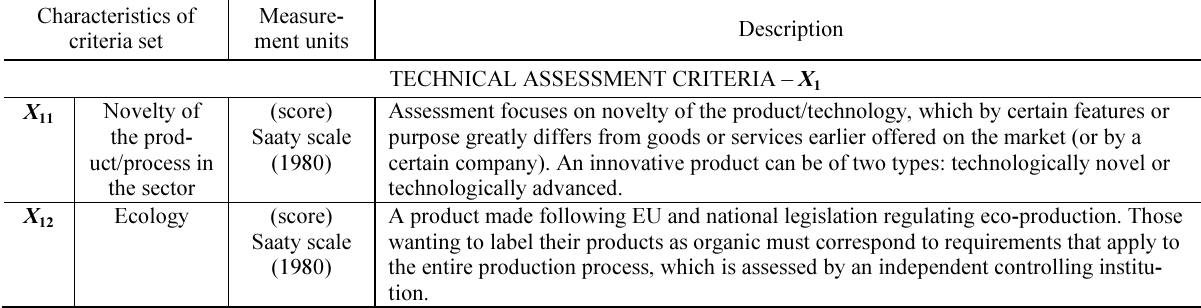
Table 1. Objectives used to assess the micro environment for technology deployment Characteristics